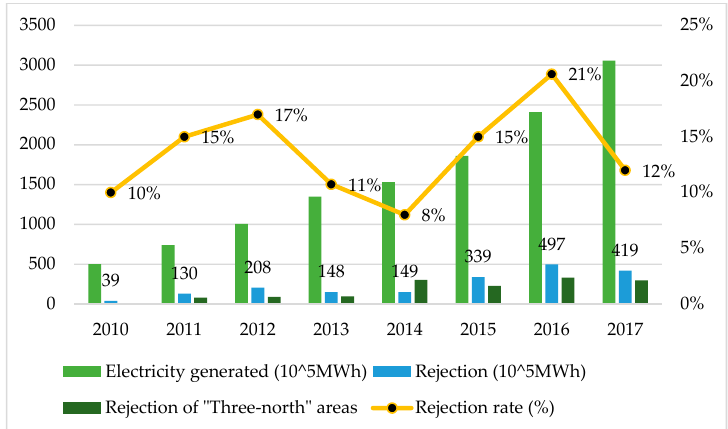
Figure 10. Wind power generation and rejection situation in China in 2010–2017. (Data source: the electricity generated data and rejection data of 2010 to 2012 was from [4,14]. From this, the corresponding rejection rate was calculated, and we modified partial data from the Electricity Regulatory Annual Report 2010 reported by China’s Central People’s Government [66]. Other electricity generated data and rejection data are collected from the annual wind power development report from the website of NEA. Data regarding the rejection rates of the “Three-north” areas are integrated from [10,62,67–69]).